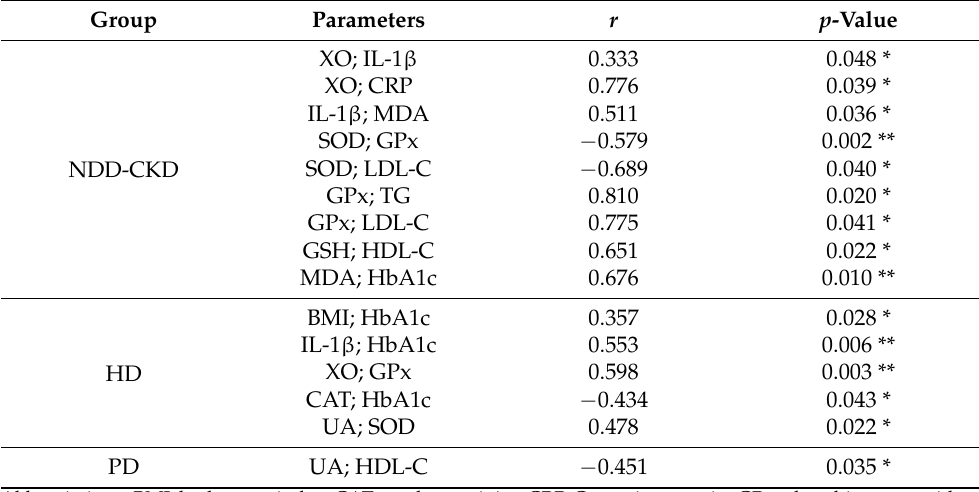
Table 3. Pearson ´ s correlation coefficients ( r ) between selected biochemical, inflammatory and oxidative stress parameters in plasma of study participants. Group